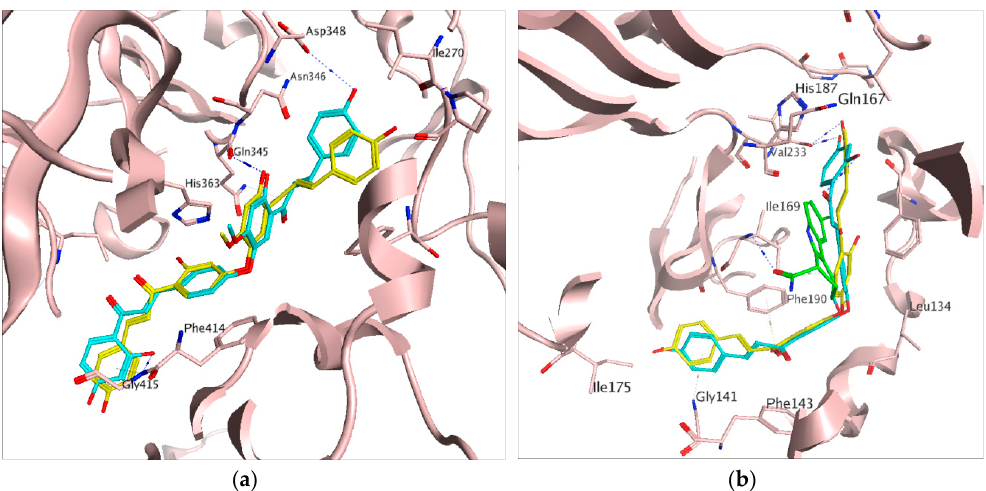
Figure 3. Predicted common binding mode of active compounds in the peptide binding pockets of ( a ) sirt1 (PDB ID: 4ZZJ) and ( b ) sirt2 (PDB ID: 4R8M). In both cases, compound 8 in yellow, compound 9 in cyan, hydrogen bonds drawn as dashed lines, while EX-243 is shown in green on subfigure ( b ). The same interactions were observed for the myristol peptide as well in the X-ray structure of Sirt2, but not with the indole derivative EX-243 (Figure 3b). Within the sirt2 extended C pocket (Figure S4), the hydroxyl groups of the B’ ring of the actives interact with His187 via the co- crystallized water molecule HOH676. Meanwhile, the hydroxyl groups of ring A interact with the O atom of Asp 170 in the backbone and the carbonyl groups (near the ring A’) interact with the side chain of IIe232 (Figure S4). Binding in the peptide pockets of both sirt1 and sirt2 is driven by